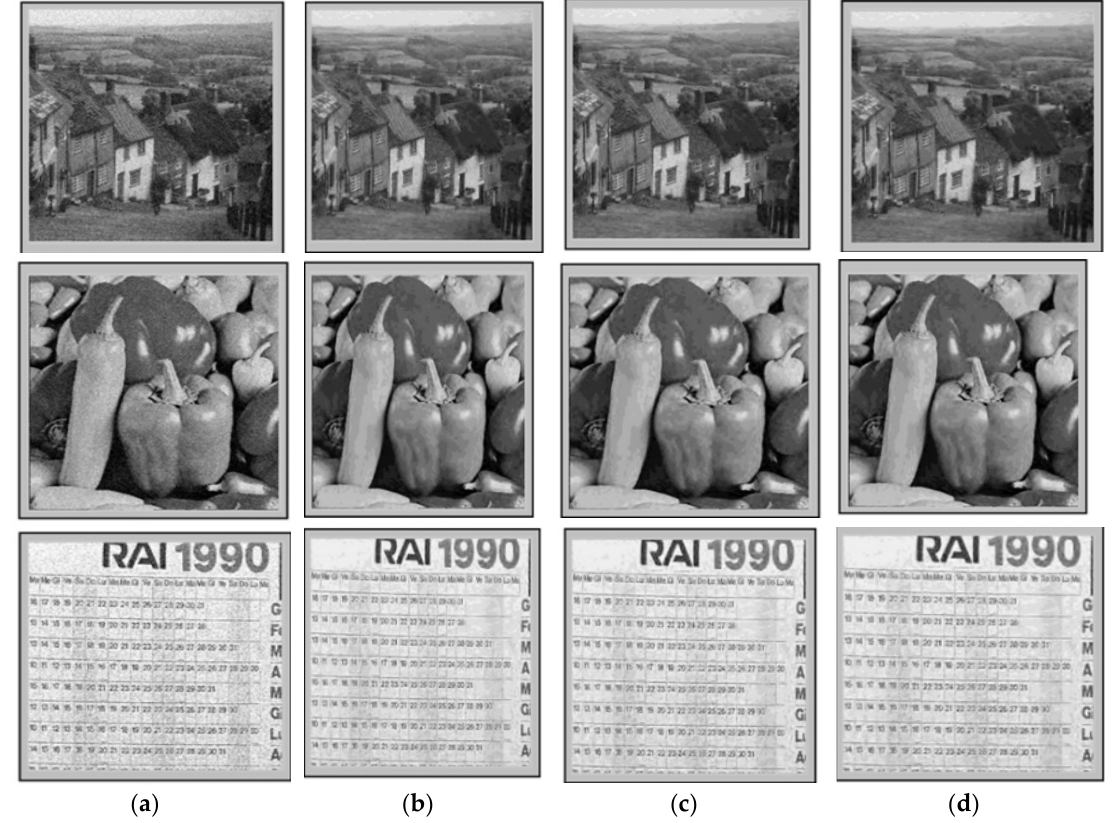
Figure 5. Images processed by the translation invariant approach of the proposed algorithm in the two cases considered. Sixteen circular trips were considered. ( a ) Image with white additive Gaussian noise. ( b ) Image obtained by mediating the images resulting from moving the input image and processing according to the first two stages of the proposed algorithm. ( c ) Image obtained by applying the third stage of the proposed algorithm (correction depending on the contour map) on the image from point b (final result case B). ( d ) Image obtained by integrally applying the invariant to translation of the proposed algorithm. Table 6. Comparison between the correction methods based on the hierarchical correlation map. The test images are 256 × 256 pixels and have been degraded with white Gaussian additive noise. Initial Switched Type Correction Continuous Type Image σ